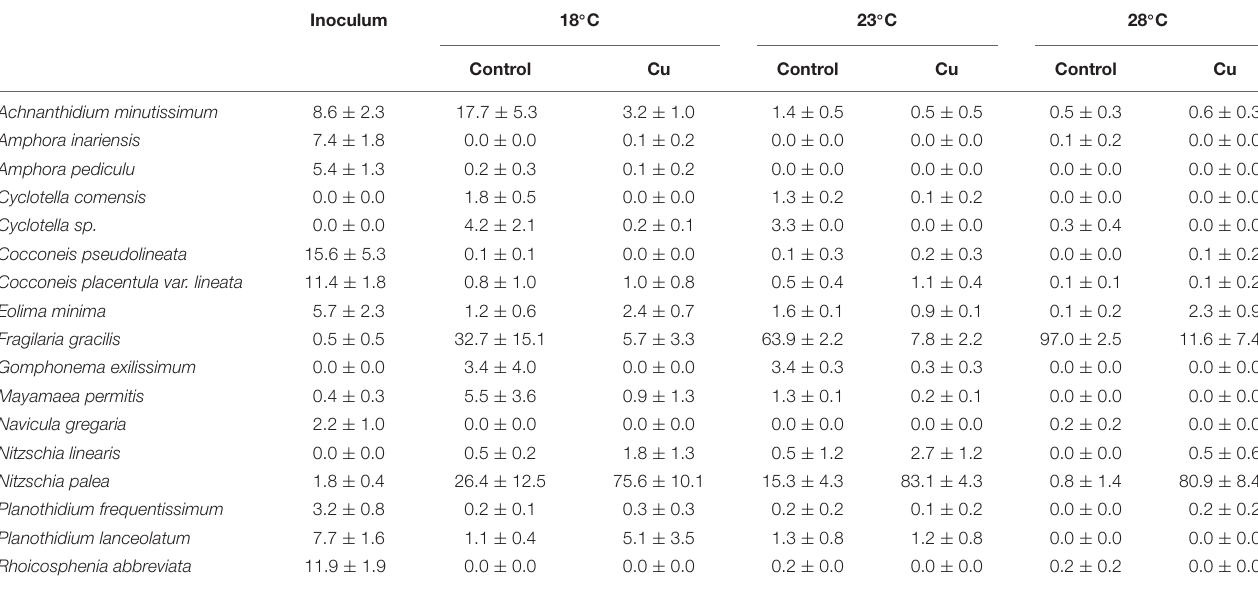
TABLE 2 | Mean relative abundances ( ± SD; n = 3) of the 17 dominant diatom species (i.e., representing more than 3% relative abundances in at least one sample) for the inoculum and the six thermal and exposure contexts at week